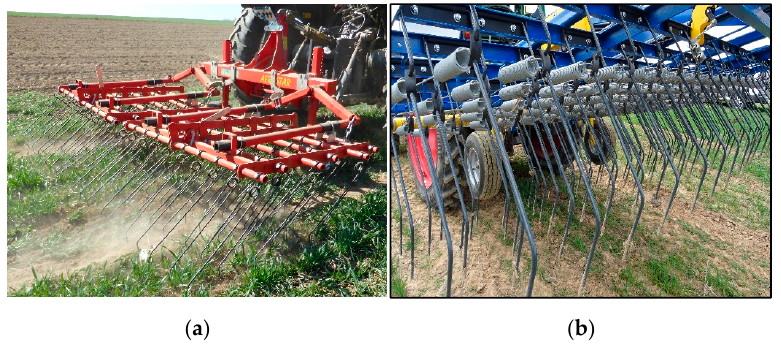
Figure 1. ( a ) Conventional harrow with manual tine adjustment (Einboeck Aerostar, Einböck GmbH & Co.KG, Dorf an der Pram, Austria) and a tine diameter of 7 mm used in all experiment in Renningen and Forchheim; ( b ) harrow with an automatic tine pressure control system in combination with an additional electronical depth guidance (TS 320, Treffler Maschinenbau GmbH & Co.KG, Pöttmes-Echsheim, Germany) and a tine diameter of 8 mm used in Odenheim 2019.